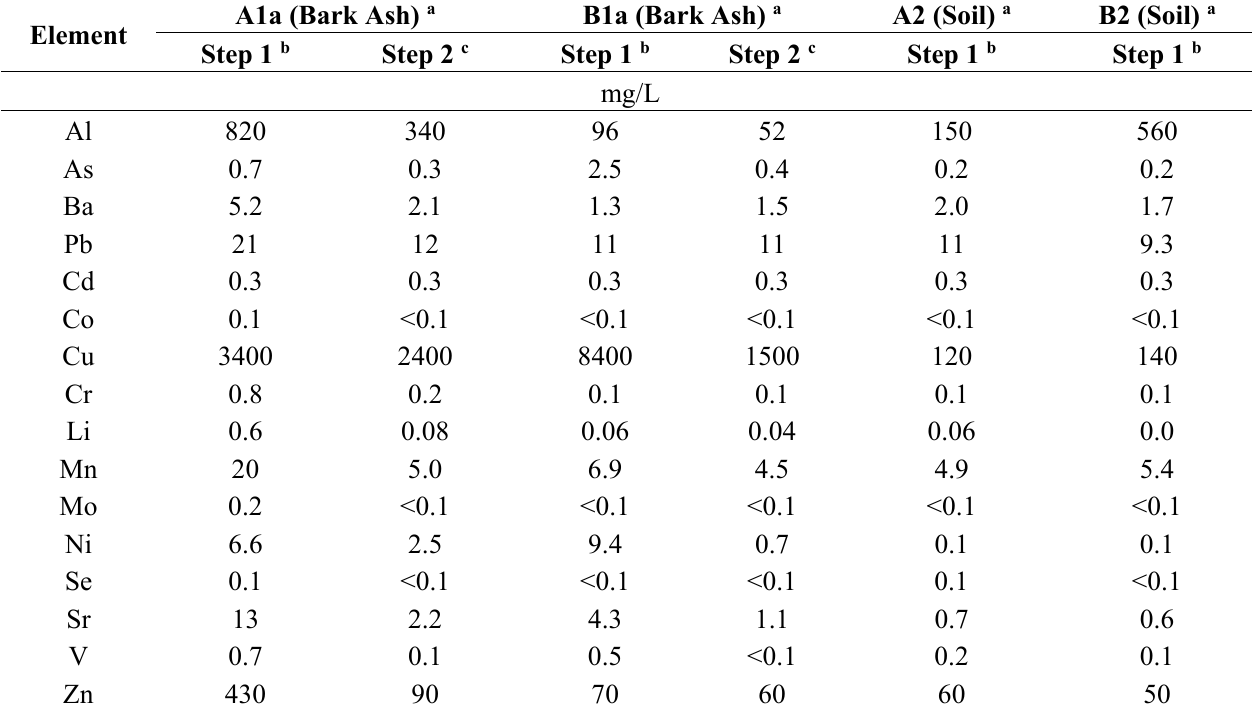
Table 2. Concentrations of selected major and minor elements in the final leachates from the ash samples A1a and B1a and from the soil samples A2 and B2. All amounts are in mg/L. Uncertainties in the analyses vary between 25% and 35%. Beryllium, Tl, U and Ag were detected in concentrations of <0.1 mg/L in all